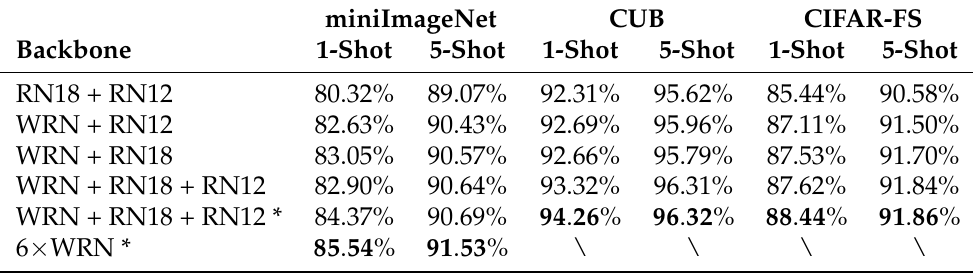
Table 9. The 1-shot and 5-shot accuracy on miniImageNet, CUB and CIFAR-FS on our proposed PEM n E-BMS with multi-backbones (backbone training procedure follows [2], ’+’ denotes a concate- nation of backbone